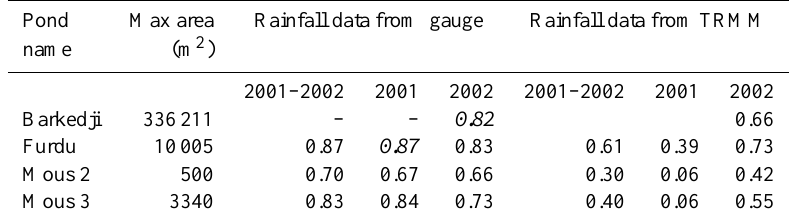
Fig. 6. Comparison of water heights field data (in black) with water heights simulated data from gauge rainfall (in red) and TRMM rainfall data (in green). Day 1 = 15 June 2002. Table 5. Nash coefficients for comparing water height simulations and measurements (in italic: values obtained when measurements were also used for